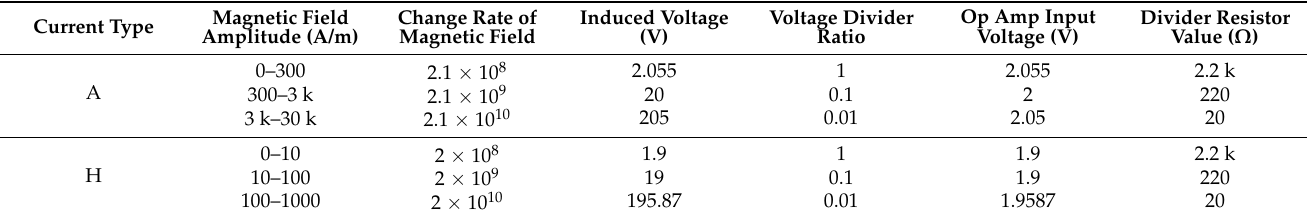
Table 1. Voltage divider resistor